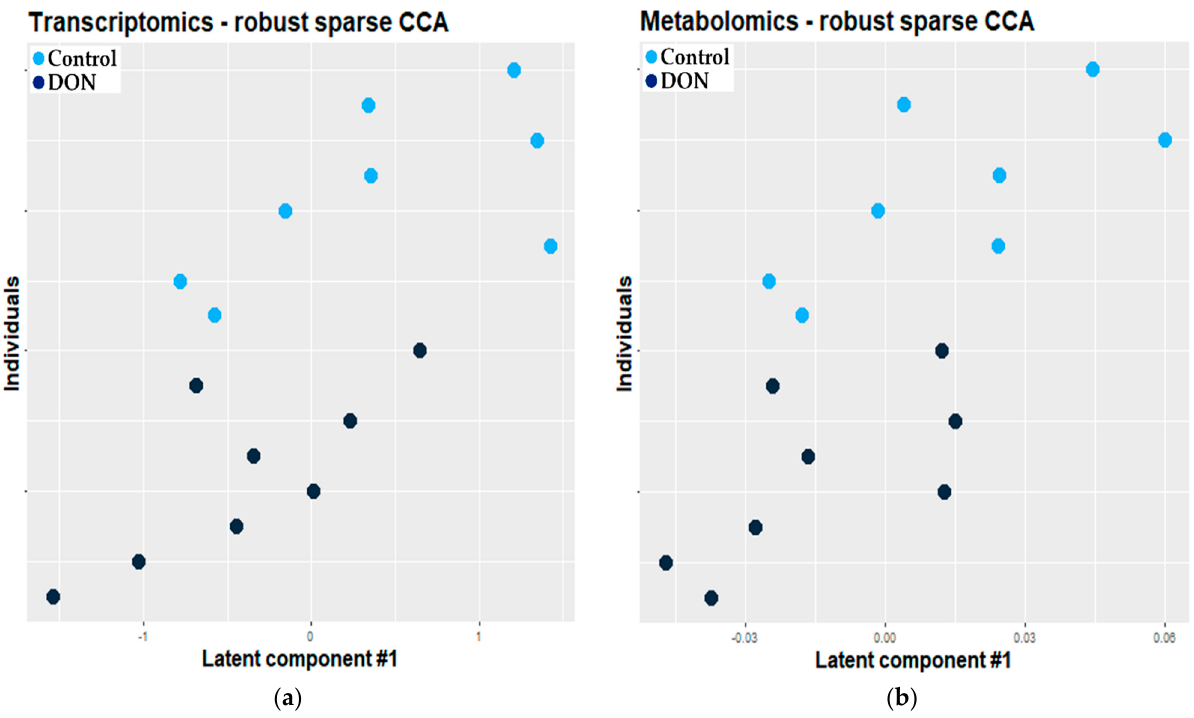
Figure 4. Projection of individuals along the first latent variable of the O2-PLS-DA model based on the features selected by rsCCA (light blue dot: control, n = 8; dark blue dot: exposed, n = 8). Each dot corresponds to an individual. ( a ) Transcriptomic dataset; ( b ) metabolomic dataset.